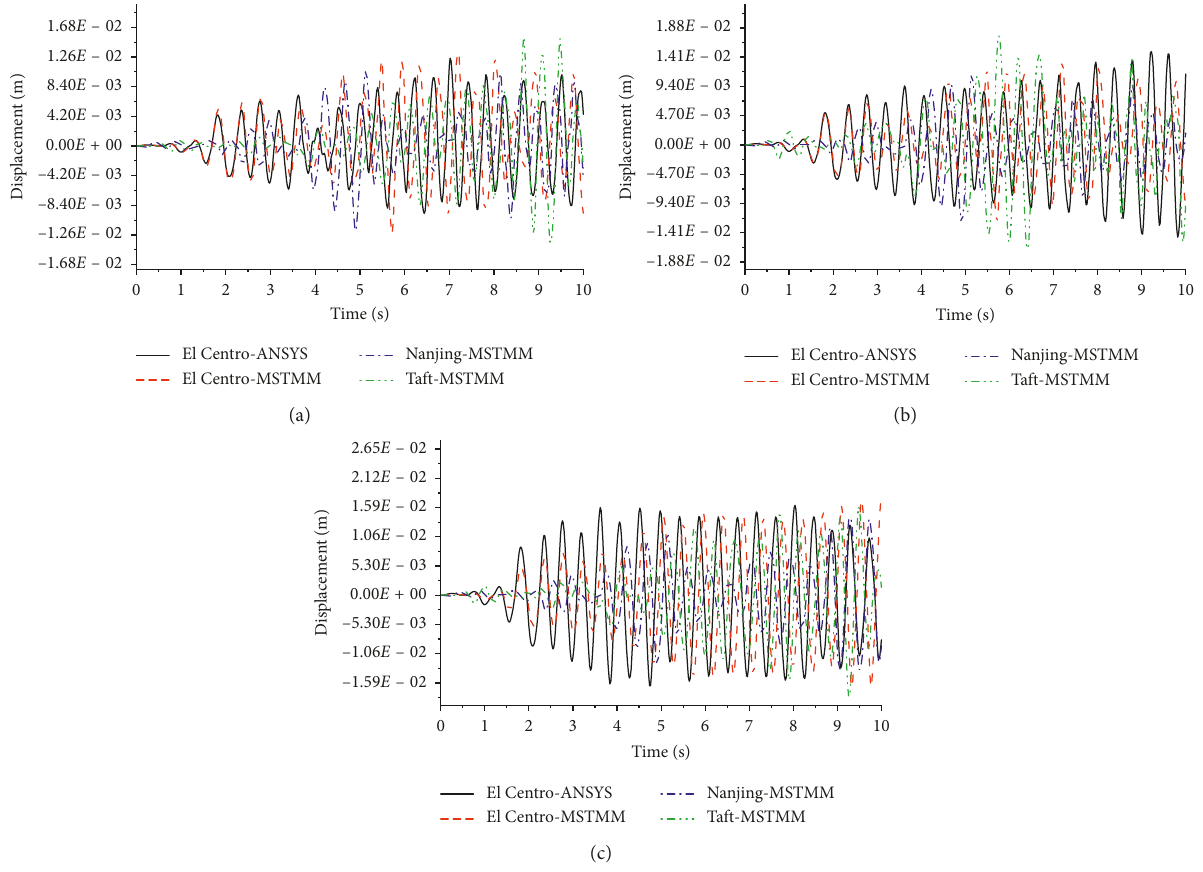
2 ). (a) 10mm,(b) 20mm, and (c)